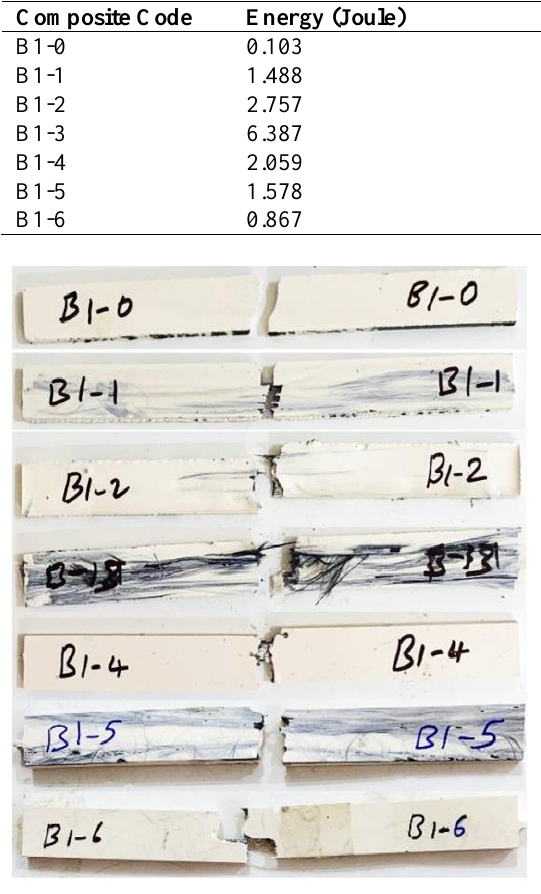
Fig. 10. Impact testing